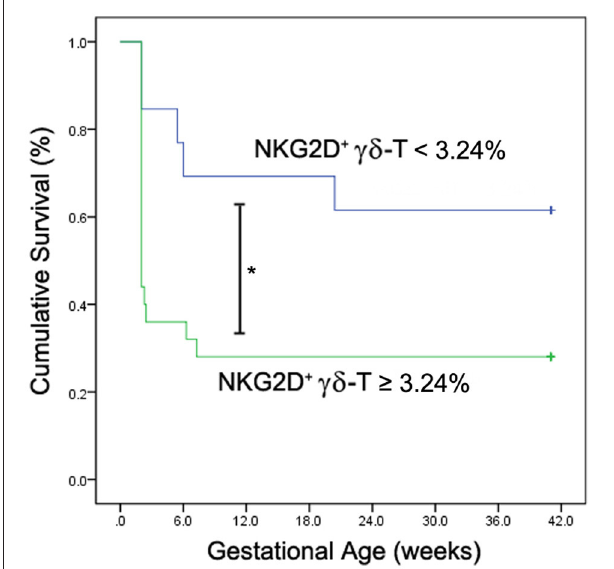
FIGURE 4 | Kaplan-Meier survival analysis of NKG2D + γδ -T cells for live birth rate in uRIF patients. The cumulative survival rate (live birth rate) was compared between uRIF patients with low frequency of NKG2D + γδ -T cells ( < 3.24%, blue line) and those with high frequency of NKG2D + γδ -T cells ( ≥ 3.24%, green line). * P < 0.05